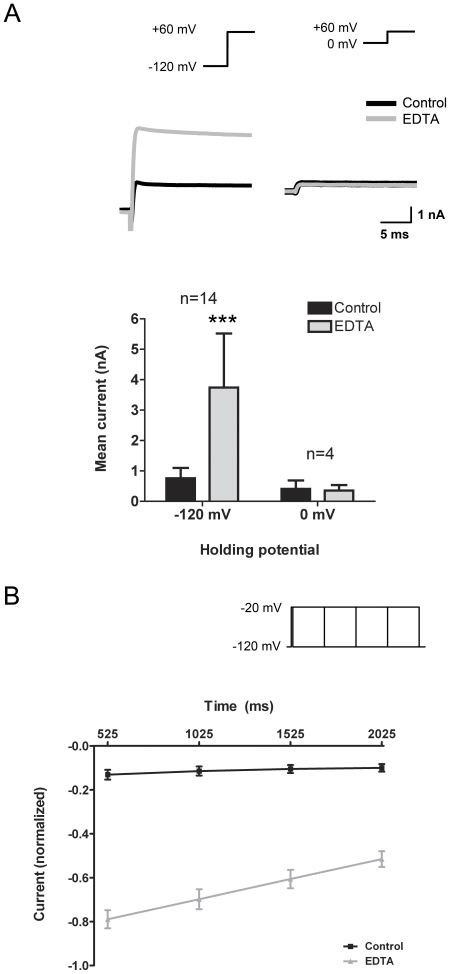

IDF exhibits voltage- and time-dependent inactivation.A, vagal neurons were held at either −120 mV or 0 mV and stepped to +60 mV for 25 ms. Current recordings are shown for a typical neuron in control solution and 5 mM EDTA (0 Ca2+, 0 Mg2+), and mean ± S.E.M. data are shown below. Statistical analysis was carried out between control conditions and addition of 5 mM EDTA using the paired Student's t-test (*** p<0.005). B, vagal neurons held at −120 mV were stepped to −20 mV for different durations: 25, 525, 1025, 1525 and 2025 ms. The peak amplitude of the tail currents (mean ± S.E.M) for the 525, 1025, 1525 and 2025 ms time points was normalized to the current recorded at the 25 ms (n = 8).